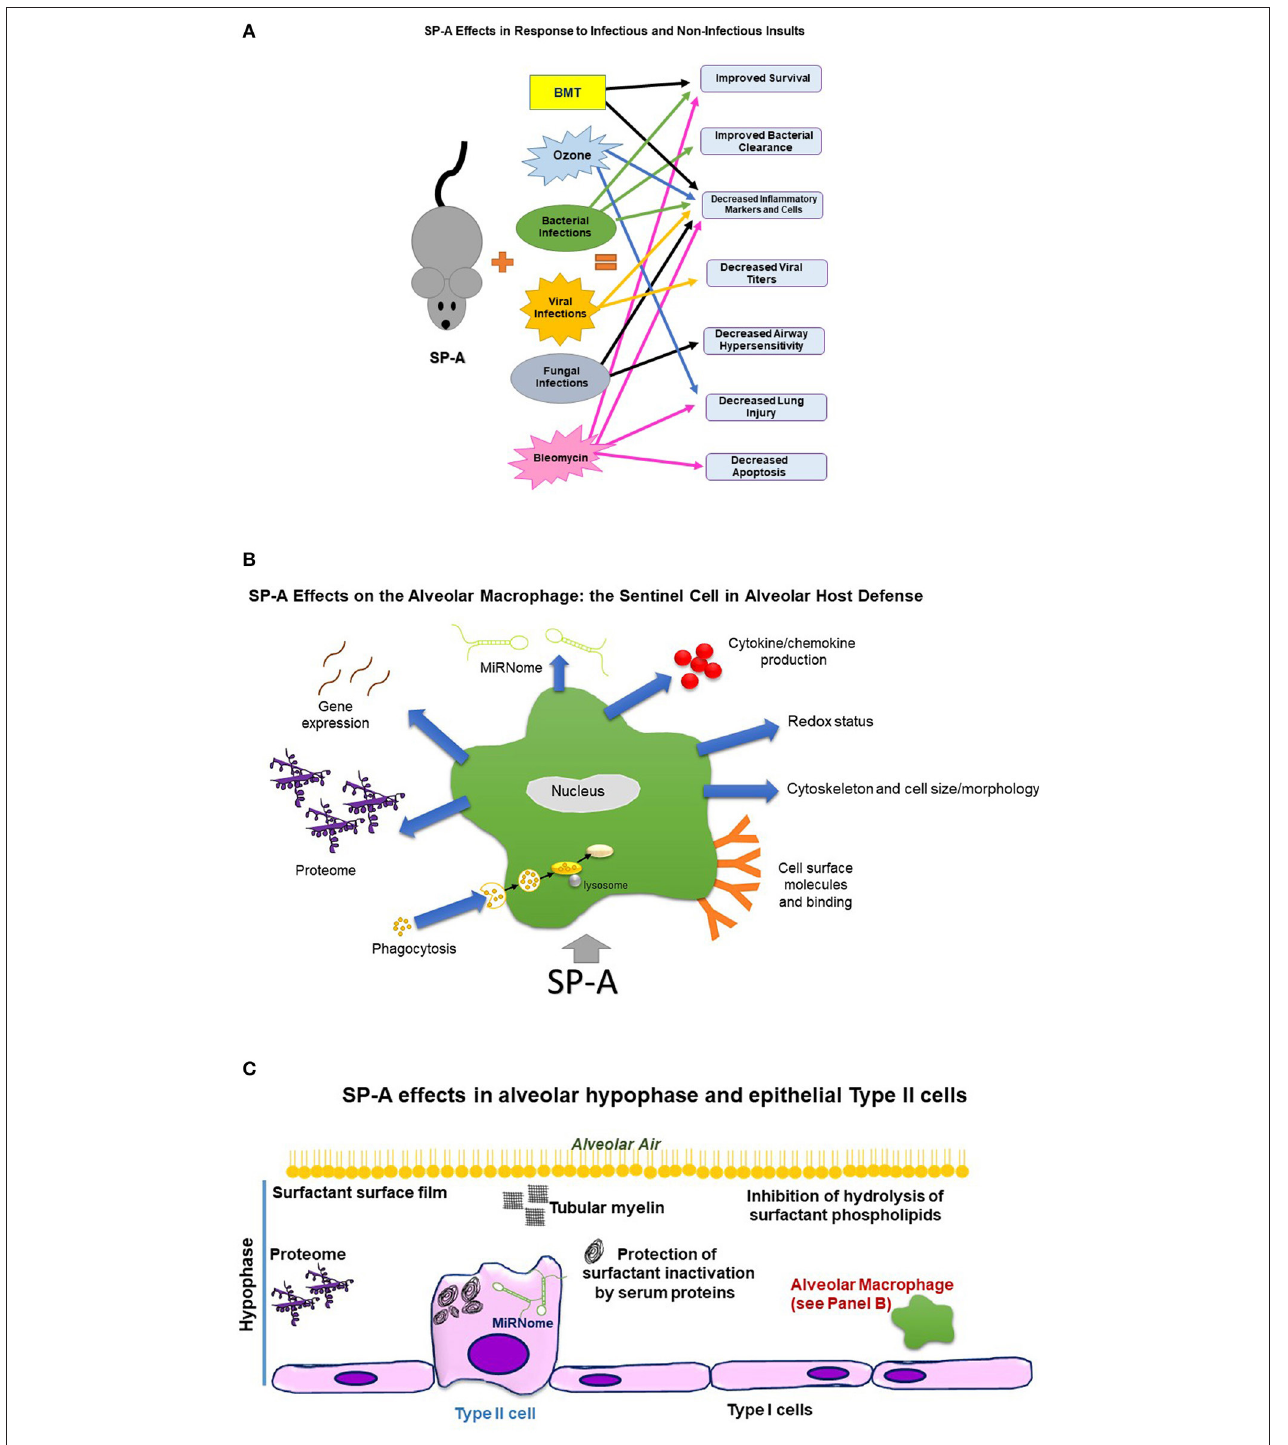
FIGURE 1 | This figure depicts diagrammatically effects of SP-A on the organism, alveolar macrophage, and alveolar hypophase, as assessed by comparison of SP-A KO mice to WT or SP-A KO carrying a human SP-A transgene. (A) Depicts effects of SP-A on the organism in response to infectious and non-infectious insults. BMT, Bone marrow transplantation. Sex differences were observed in survival after bacterial infection, clearance of bacteria, dissemination of infection, robustness of response to infection, extrapulmonary lesions, and airway function readouts. SP-A in response to double insults, such as infection and ozone exposure, improved survival. (B) Depicts effects of SP-A on the alveolar macrophage, the sentinel alveolar host defense cell. Sex differences were observed in proteome, gene expression, miRNome, cytoskeleton, and redox status. (C) Depicts SP-A effects in the alveolar hypophase and epithelial Type II cells. Sex differences were observed in the miRNome of the epithelial Type II